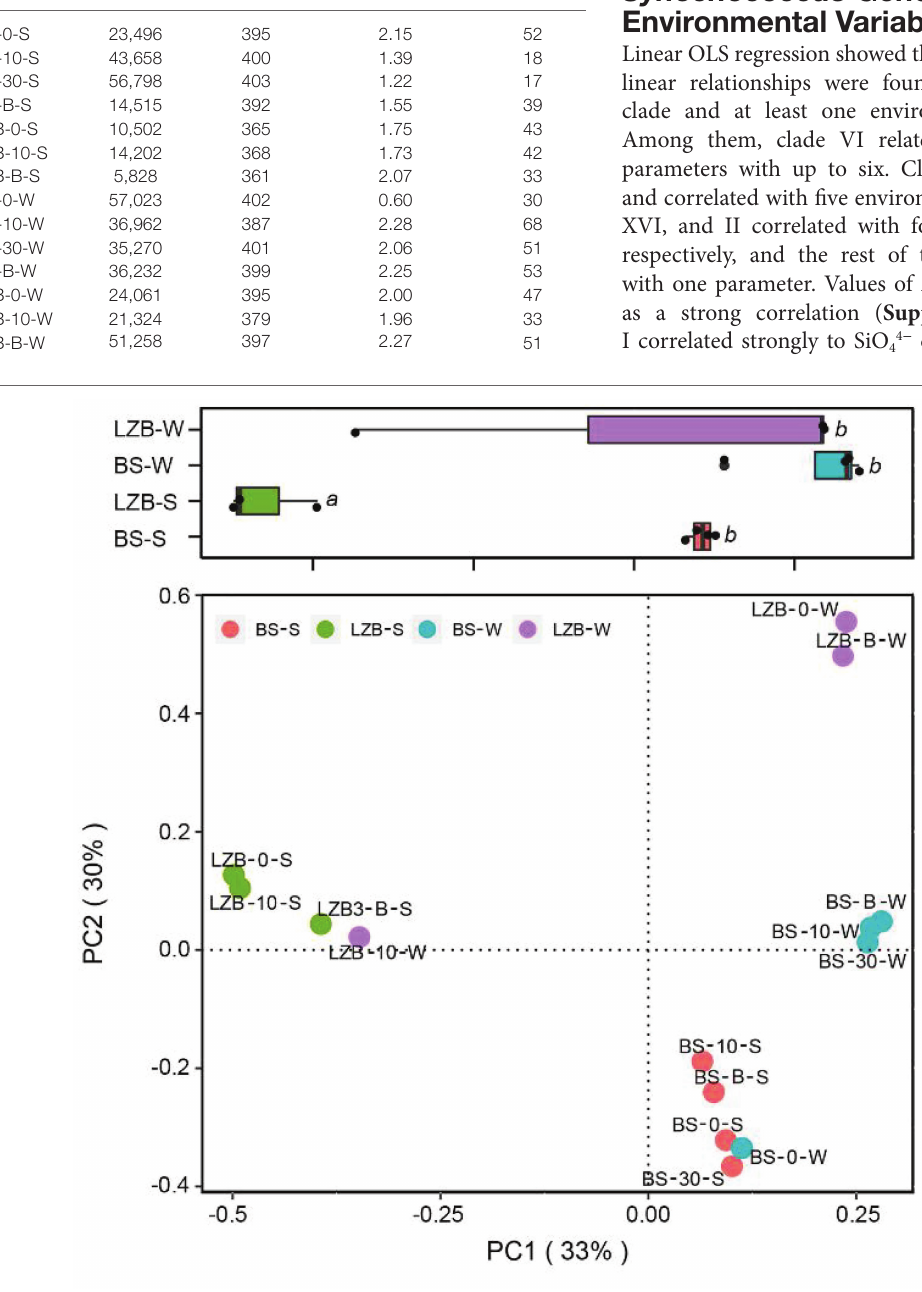
FIGURE 2 | The principal coordinate analysis (PCoA) with permutational multivariate ANOVA (PERMANOVA) test showing the variation in Synechococcus assemblages at operational taxonomic units (OTU) level among samples at different stations and in different months. BS-S, samples at station Bohai Strait (BS) in summer (June); BS-W, samples at station BS in winter (November); LZB-S, samples at station Laizhou Bay (LZB) in summer (June); LZB-W, samples at station LZB in winter (November).